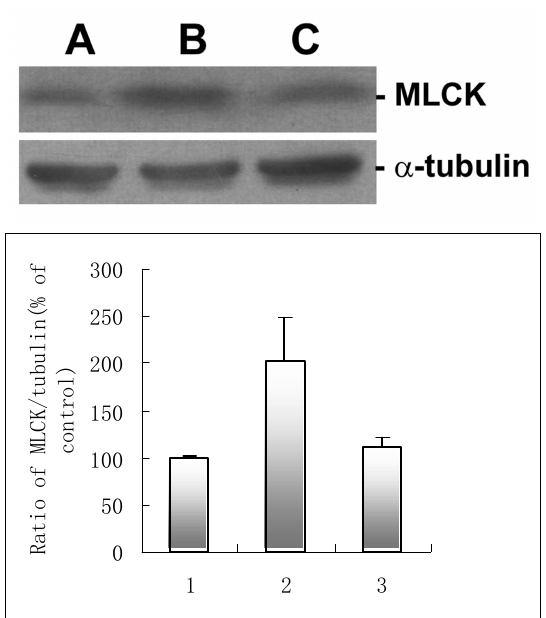
Figure 3. Western blot analysis of MLCK was performed in kidney of from control, streptozotocin- diabetes and insulin-treated rats. Kidney homogenates were prepared as described in